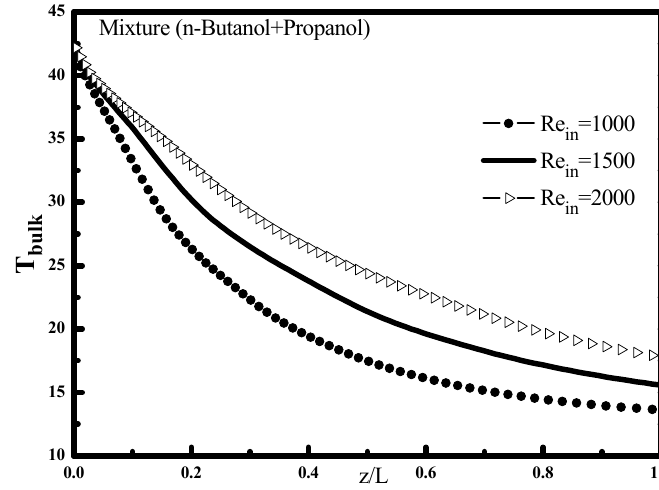
Figure 7. Variation of the mixture temperature along the tube for different Re in